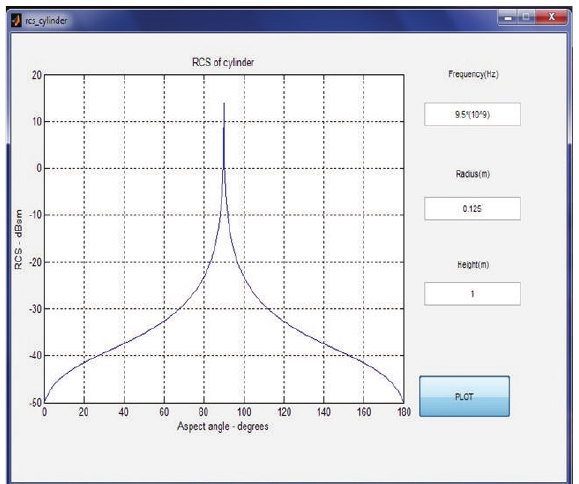
Figure 17: GUI for RCS of cylinder.